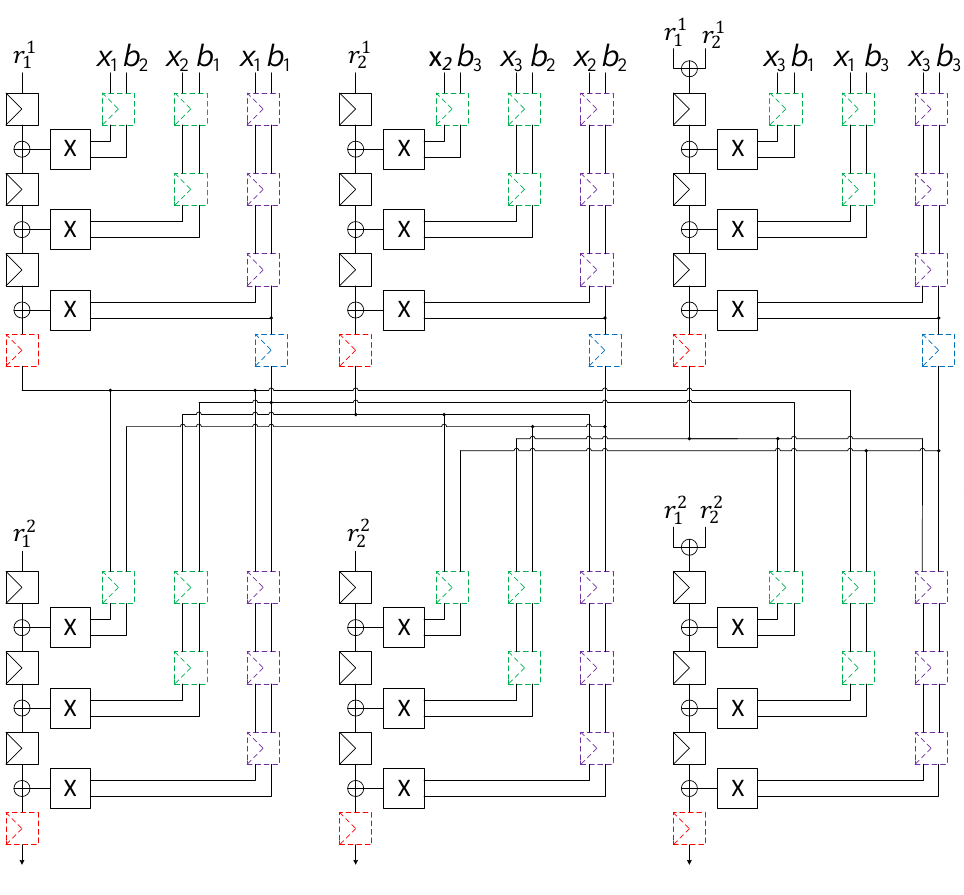
Figure 10: Composition of two UMA multiplications ( d = 2) with several kinds of (mandatory and optional) pipelining and synchronization register